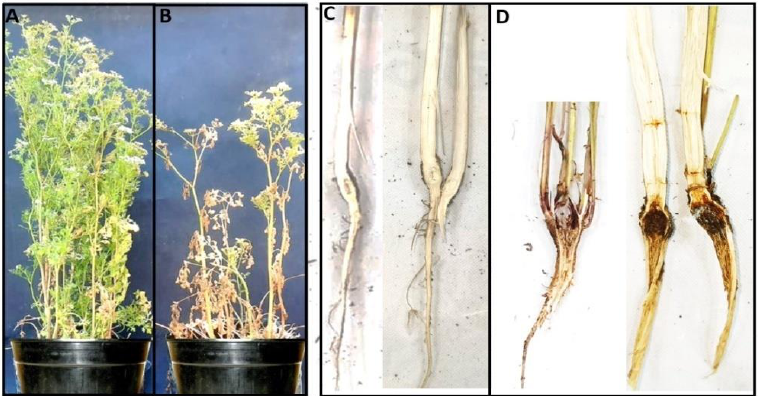
Figure 1. Pathogenicity test of R. solani against coriander. ( A ) Healthy uninfected plant, ( B ) root rot wilt symptoms on R. solani -infected plants appeared as yellowing, stunting, and wilting. ( C ) Longitudinal section in healthy coriander root, no rot or discoloration were detected. ( D ) Longi- tudinal section showing root rot/wilt symptoms in infected coriander